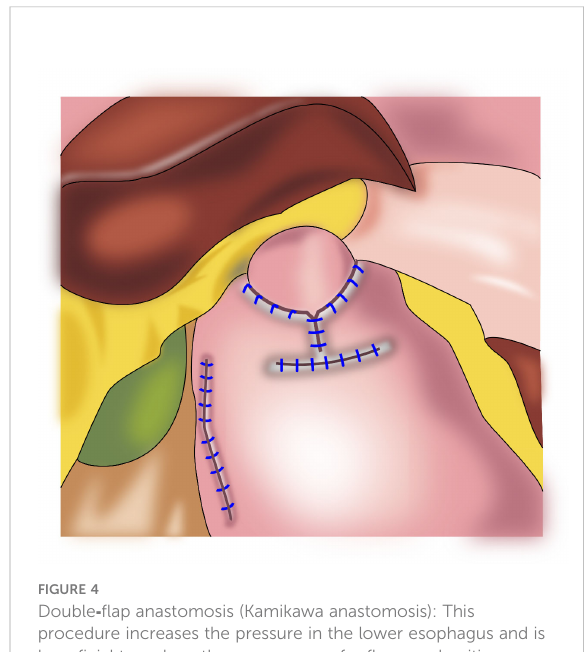
FIGURE 4 Double ⁃ fl ap anastomosis (Kamikawa anastomosis): This procedure increases the pressure in the lower esophagus and is bene fi cial to reduce the occurrence of re fl ux